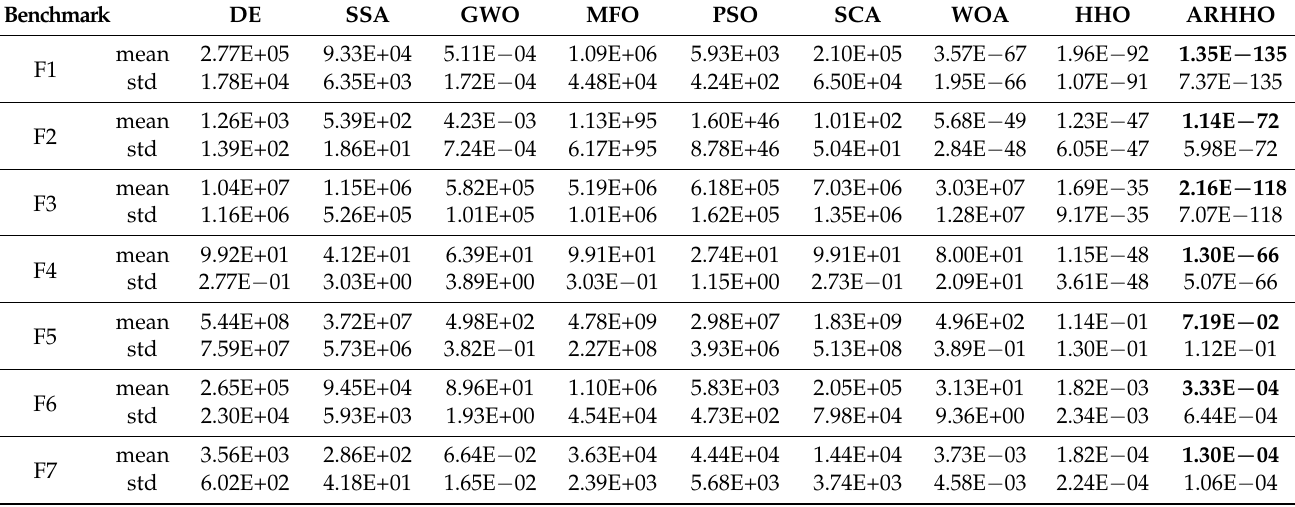
Table 4. Experimental results of benchmark functions F1~F13 in 500